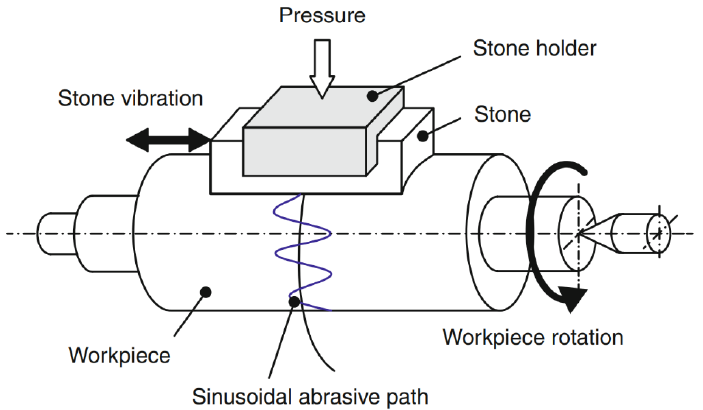
Figure 14. Schematic diagram of superfinishing process [96]. Reprinted with permission from [96]; 2014 Springer.